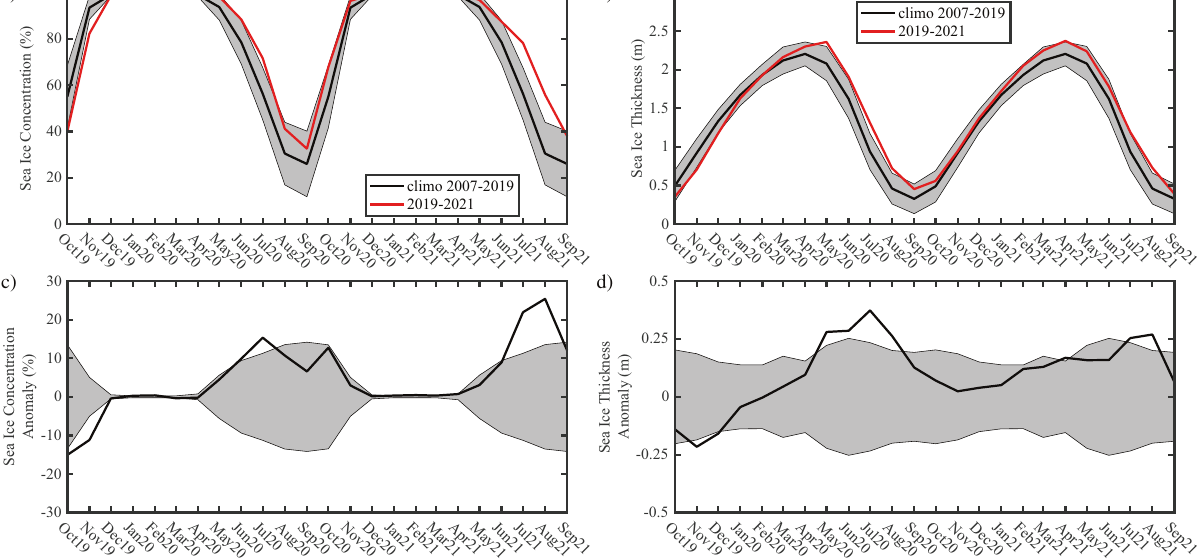
Fig. 3 Monthly mean Beaufort Sea ice characteristics from October 1 2019 – September 30 2021. Time series (red curves) of the ( a ) monthly mean sea ice concentration (%) from the NSIDC CDR dataset and ( b ) monthly mean sea ice thickness (m) from PIOMAS with the climatological monthly mean values shown in black with one standard deviation above/below the mean indicated by the shading. The climatology is based on 2007 – 2019. In ( c ) and ( d ), the corresponding anomalies are shown with the shading representing + / − one standard